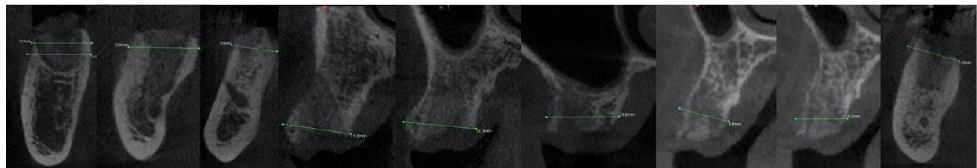
Figure 5. CBCT images of the nine consecutive cases at baseline, before the surgery.